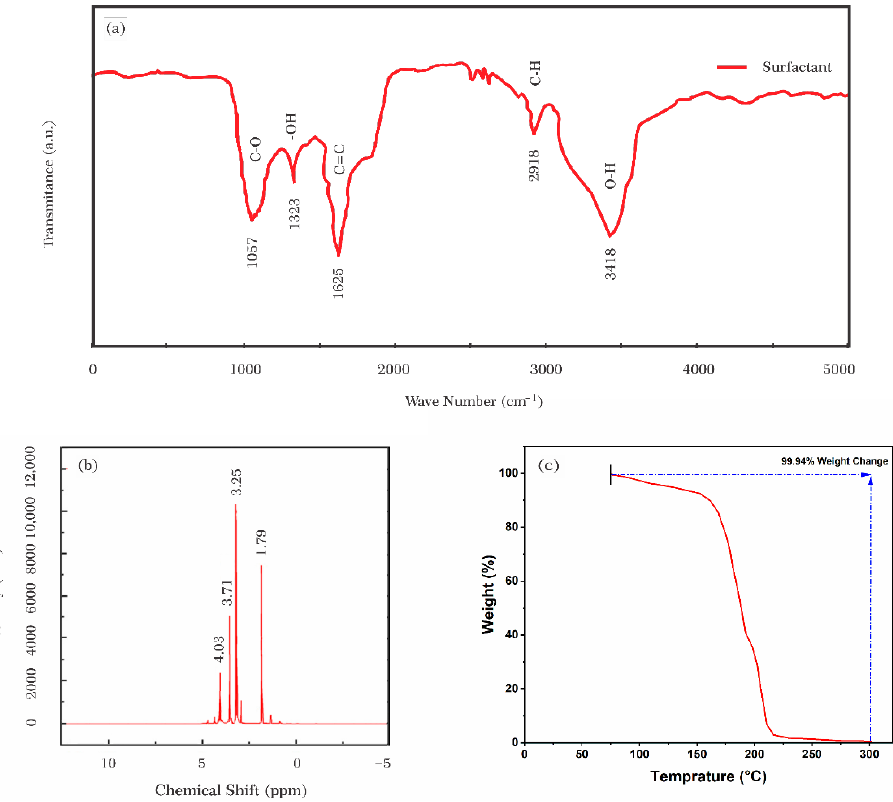
Figure 6. ( a ) FT-IR spectrum ( b ) 1 H-NMR spectrum and ( c ) TGA analysis of Azarboo